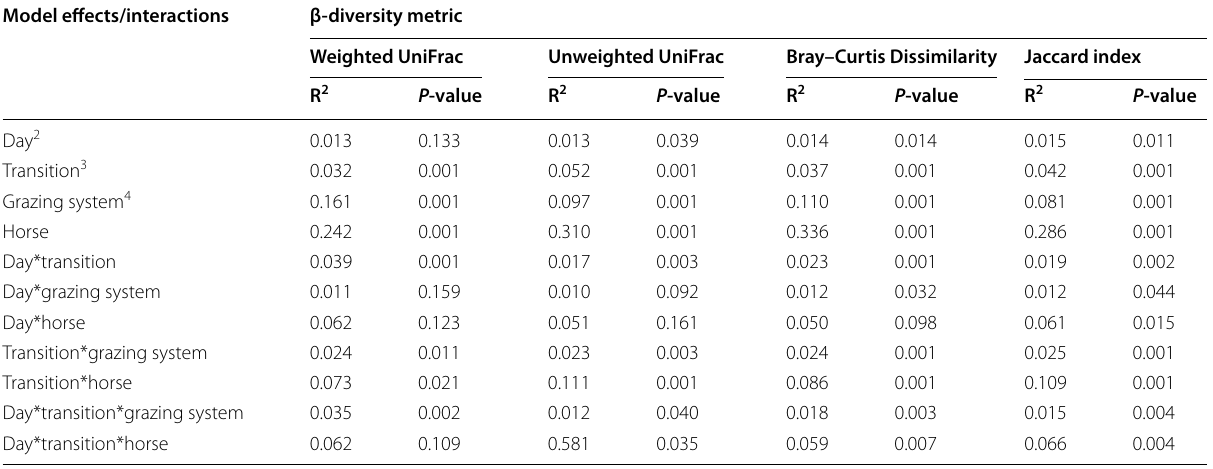
Table 1 Results of Adonis 1 multivariate PERMANOVA analysis of β‑diversity showing influence of main effects and interactions